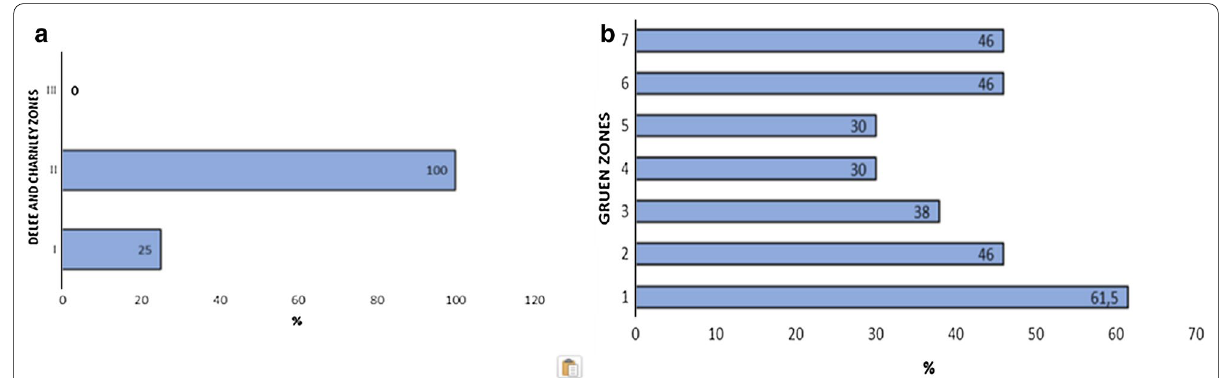
Fig. 2 Bar chart showing the percentage of peri-prosthetic osteolysis according to DeLee and Charnley ( a ) and Gruen ( b ) classifications